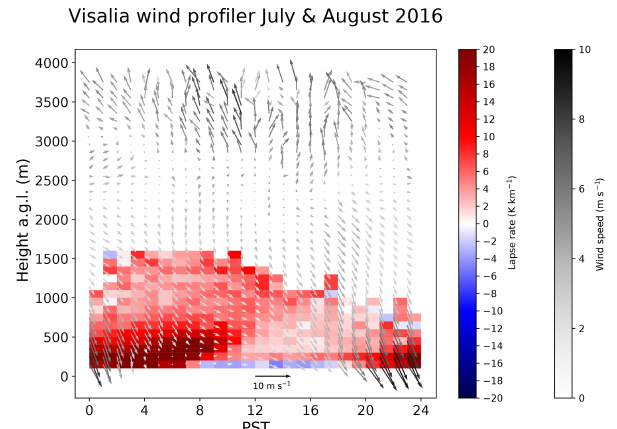
Figure 14. Stability and wind quivers for the Visalia 915MHz sounder, 1 July–31 August